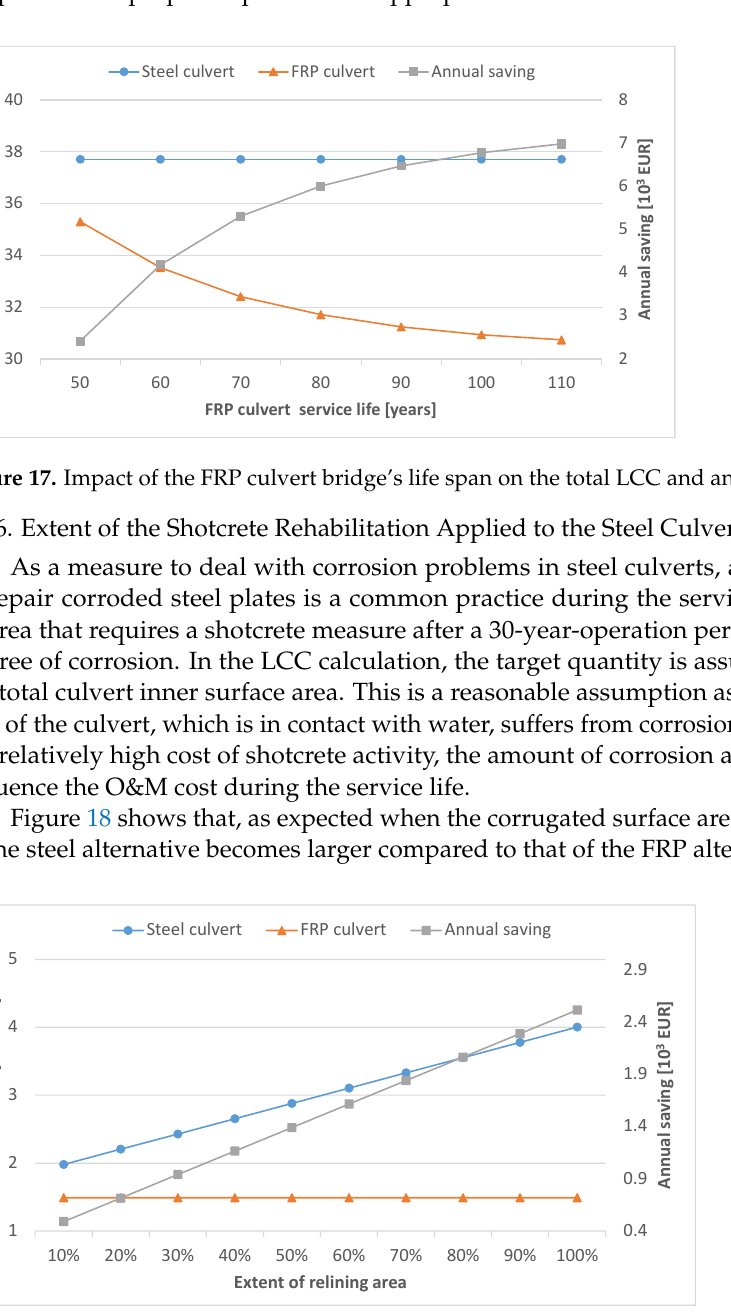
Figure 16. Impact of the steel culvert structure price on the LCC and annual saving.